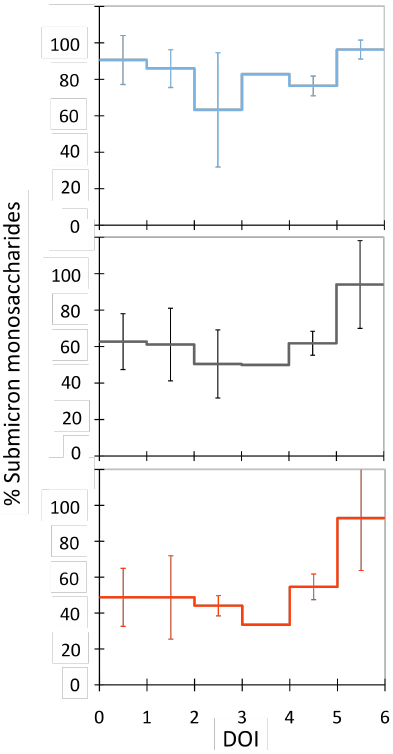
Fig. 8. Relative sub-micrometer (Aitken and accumulation mode) to total mass (%), of deoxysugars (light blue), THNS (dark grey), and the sum of pentoses and hexoses (red) as a function of travel time over ice (DOI). Data for all travel times of five days and longer have been collected in the column 5–6 days. Error bars indicate ± 1 σ . For 3<DIO<4, n = 1.